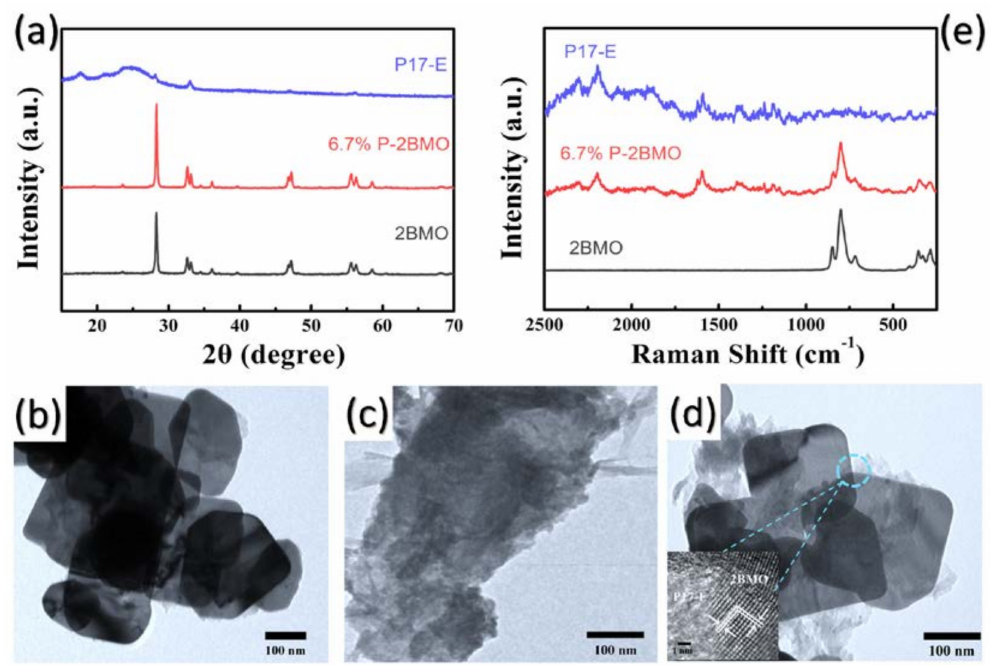
Figure 1. ( a ) X-ray diffraction (XRD) patterns of Z-scheme hybrids (2BMO), 6.7% P-2BMO, and linear pyrene-based conjugated polymer (P17-E); transmission electron microscopy (TEM) images of ( b ) 2BMO, ( c ) P17-E, and ( d ) 6.7% P-2BMO, inset shows the corresponding high-resolution transmission electron microscopy (HRTEM) images; and ( e ) Raman spectra of 2BMO, 6.7% P-2BMO, and